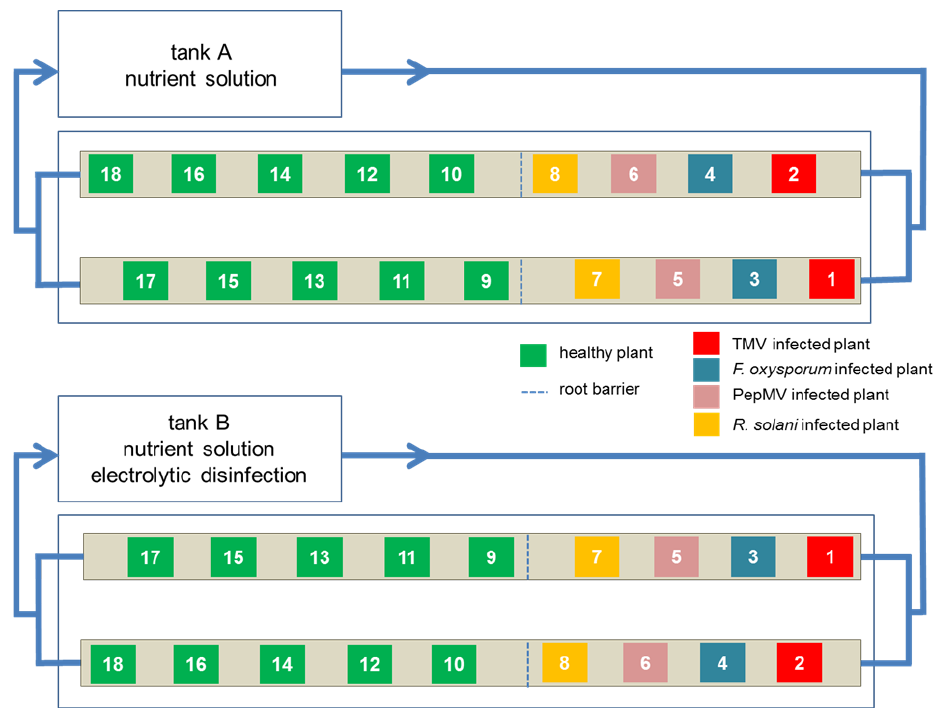
Figure 1. Schematic view of experimental set-up. Fertigation solution was continuously recirculated in the individual NFT-system by means of a pump. Each tank supplied the fertigation solution to the 18 tomato plants (8 infected and 10 healthy plants), each arranged in two rows. A root barrier (mesh size of 1626/cm 2 ) avoided root contact between infected donator plants and healthy plants. In addition to the bush growth of the tomato variety “Hoffmanns Rentita”, pruning management and spacing prevented the transmission of the pathogens from plant to plant. Only the solution in tank B was treated with the electrolytically generated disinfectant. The experiment was performed twice.